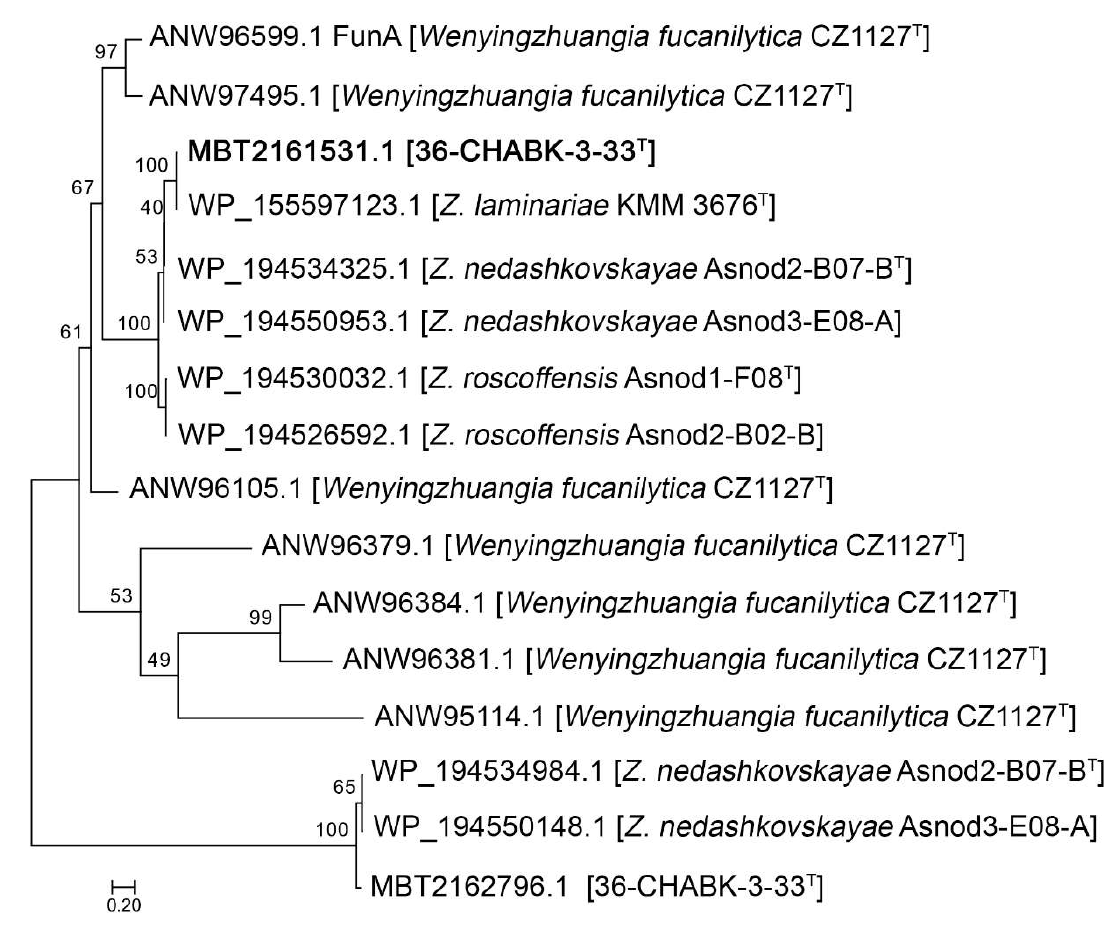
Figure 4. Maximum-likelihood phylogenetic tree of GH168 family endo-1,3-fucanase from Zobellia and selected characterized representatives of GH168 family. The ML tree was inferred using the WAG+G+I model recommended by MEGA v.7. For characterized and predicted GH168 family members, the corresponding GenBank accession numbers are given. The organism names are listed in brackets.